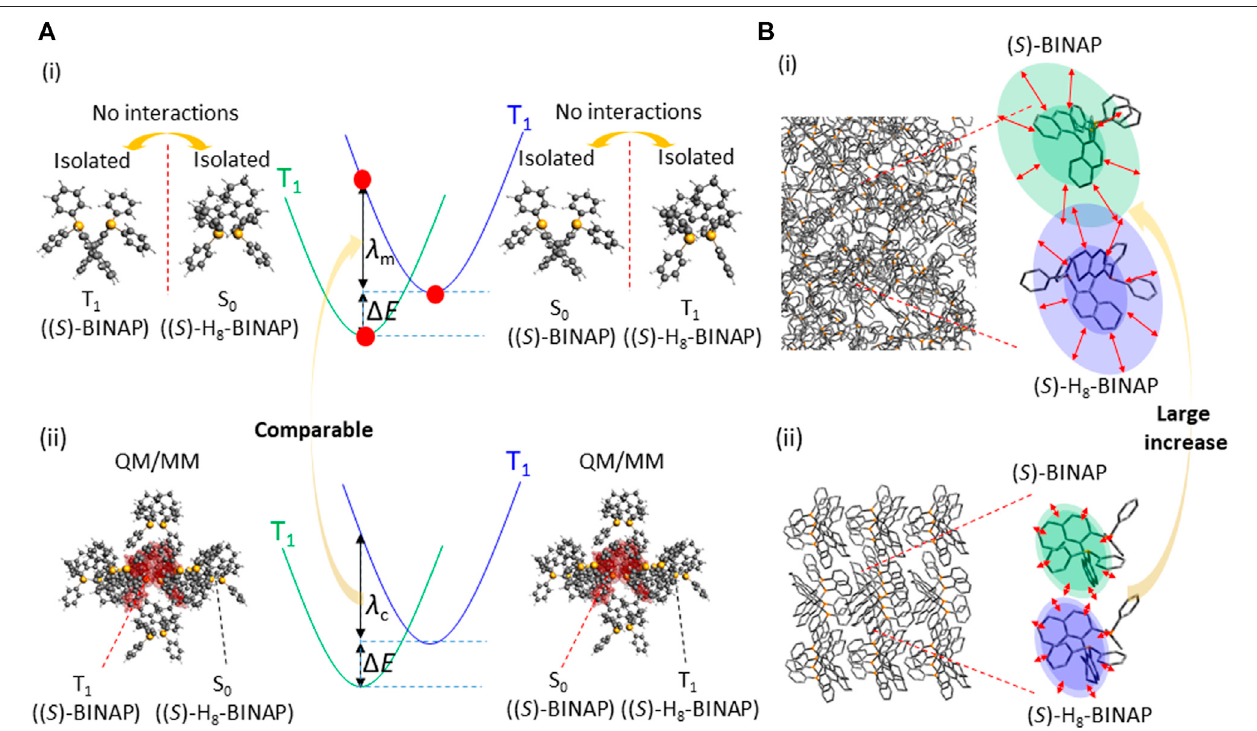
FIGURE6| Physicalbehaviorrelatingto k q (RT)exceptfor Δ E fromtheperspectiveofintermolecularinteractionsbetweenan( S )-BINAPguestandthe( S )-H 8 -BINAP host molecules. (A) Reorganization energy for endothermic triplet – triplet energy transfer. (i) represents a case in which ( S )-BINAP and ( S )-H 8 -BINAP have no intermolecularinteractions.(ii)representsacase inwhichamolecule inacrystallinelatticeof( S )-H 8 -BINAPisreplaced by( S )-BINAP. (B) Thediffusionconstant;(i)and (ii) represent the amorphous and crystallinestates, respectively.The red arrows indicate different magnitudes of the diffusion constant at RTbetween the amorphous and crystalline states. (RT (cid:1) room temperature; ( S )-BINAP (cid:1) ( S )-( − )-2,2 ′ -bis(diphenylphosphino)-1,1 ′ -binaphthyl ( S )-H 8 -BINAP (cid:1) ( S )-bis(diphenylphosphino)- 5,5 ′ ,6,6 ′ ,7,7 ′ ,8,8 ′ -octahydro-1,1 ′ -binaphthyl).